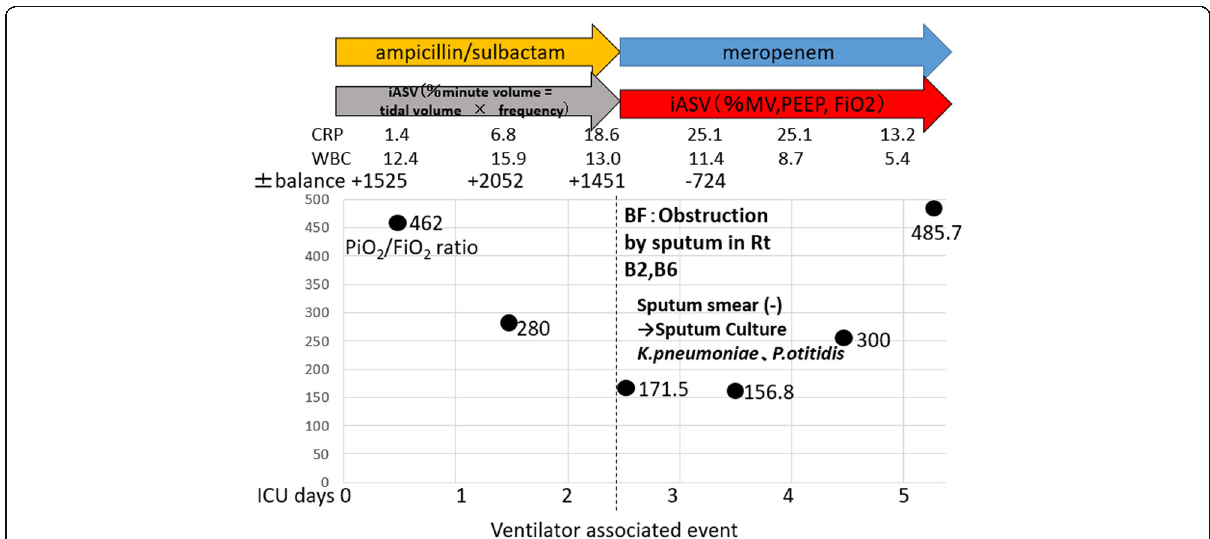
Fig. 1 Hospitalization process. At the time of entering the intensive care unit, the patient ’ s PaO 2 /FiO 2 ratio was 462(black point), which indicated a good oxygenation capacity; this decreased to 171.5 at the time of diagnosis of ventilator-associated